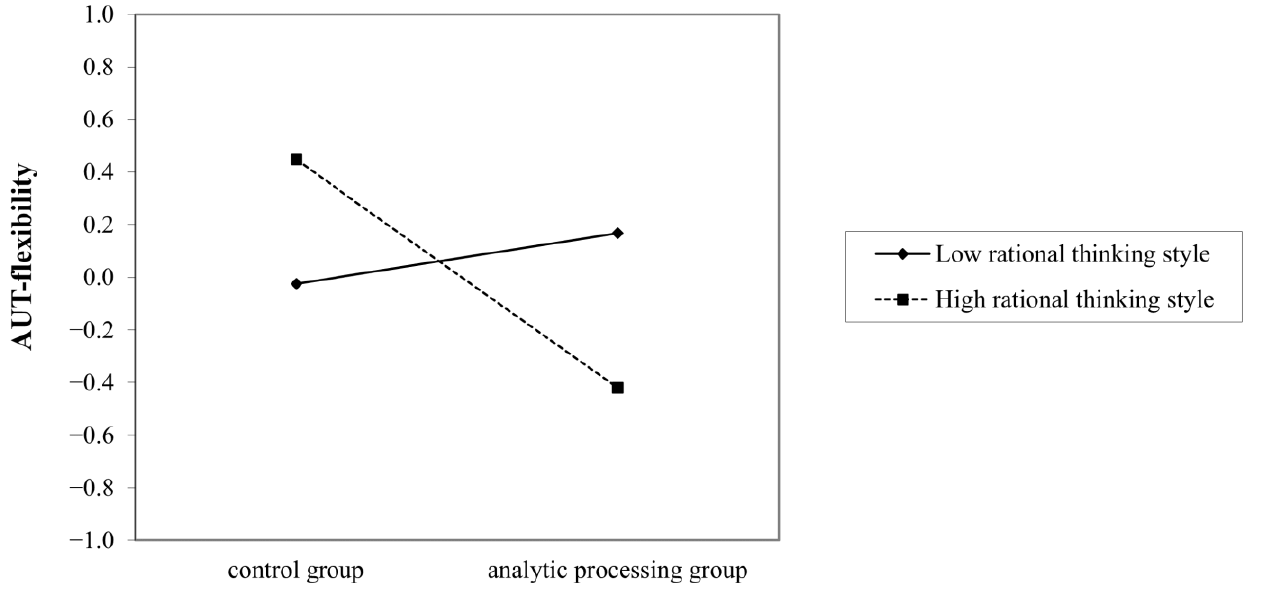
Figure 2. The interaction between rational thinking style and analytic processing prime on flexibil- ity.